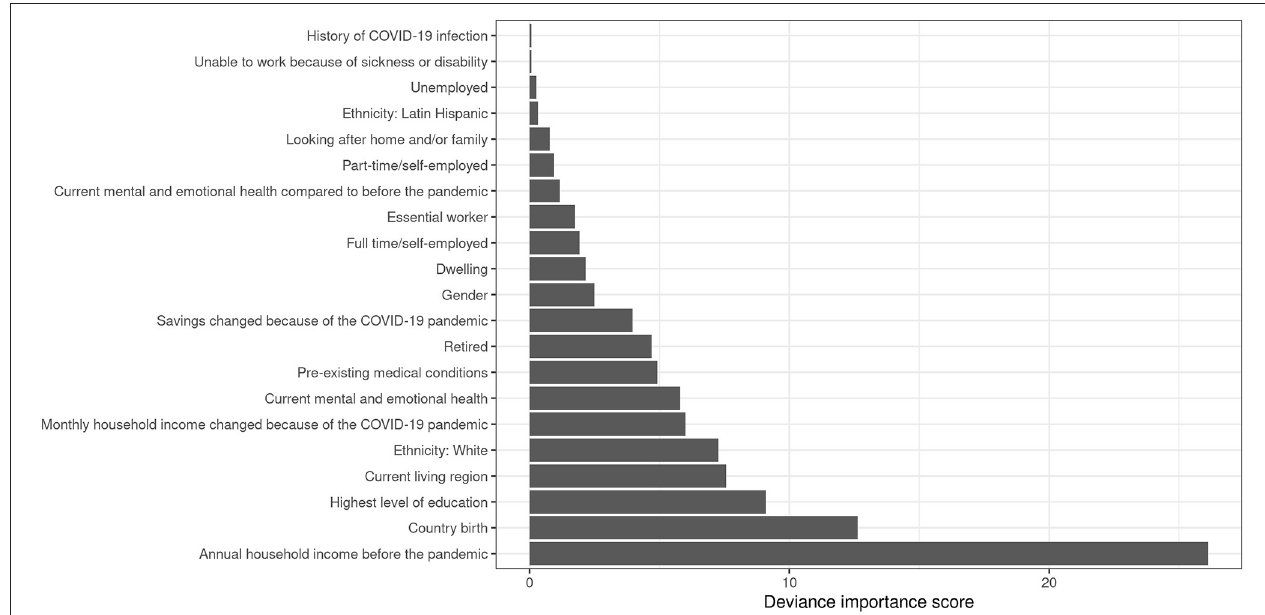
FIGURE 4 | Normalized deviance importance score of the